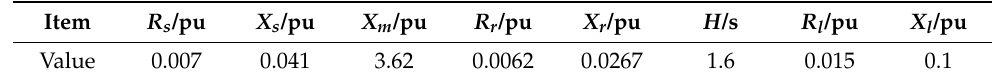
Table 1. Parameters of the single-load system.